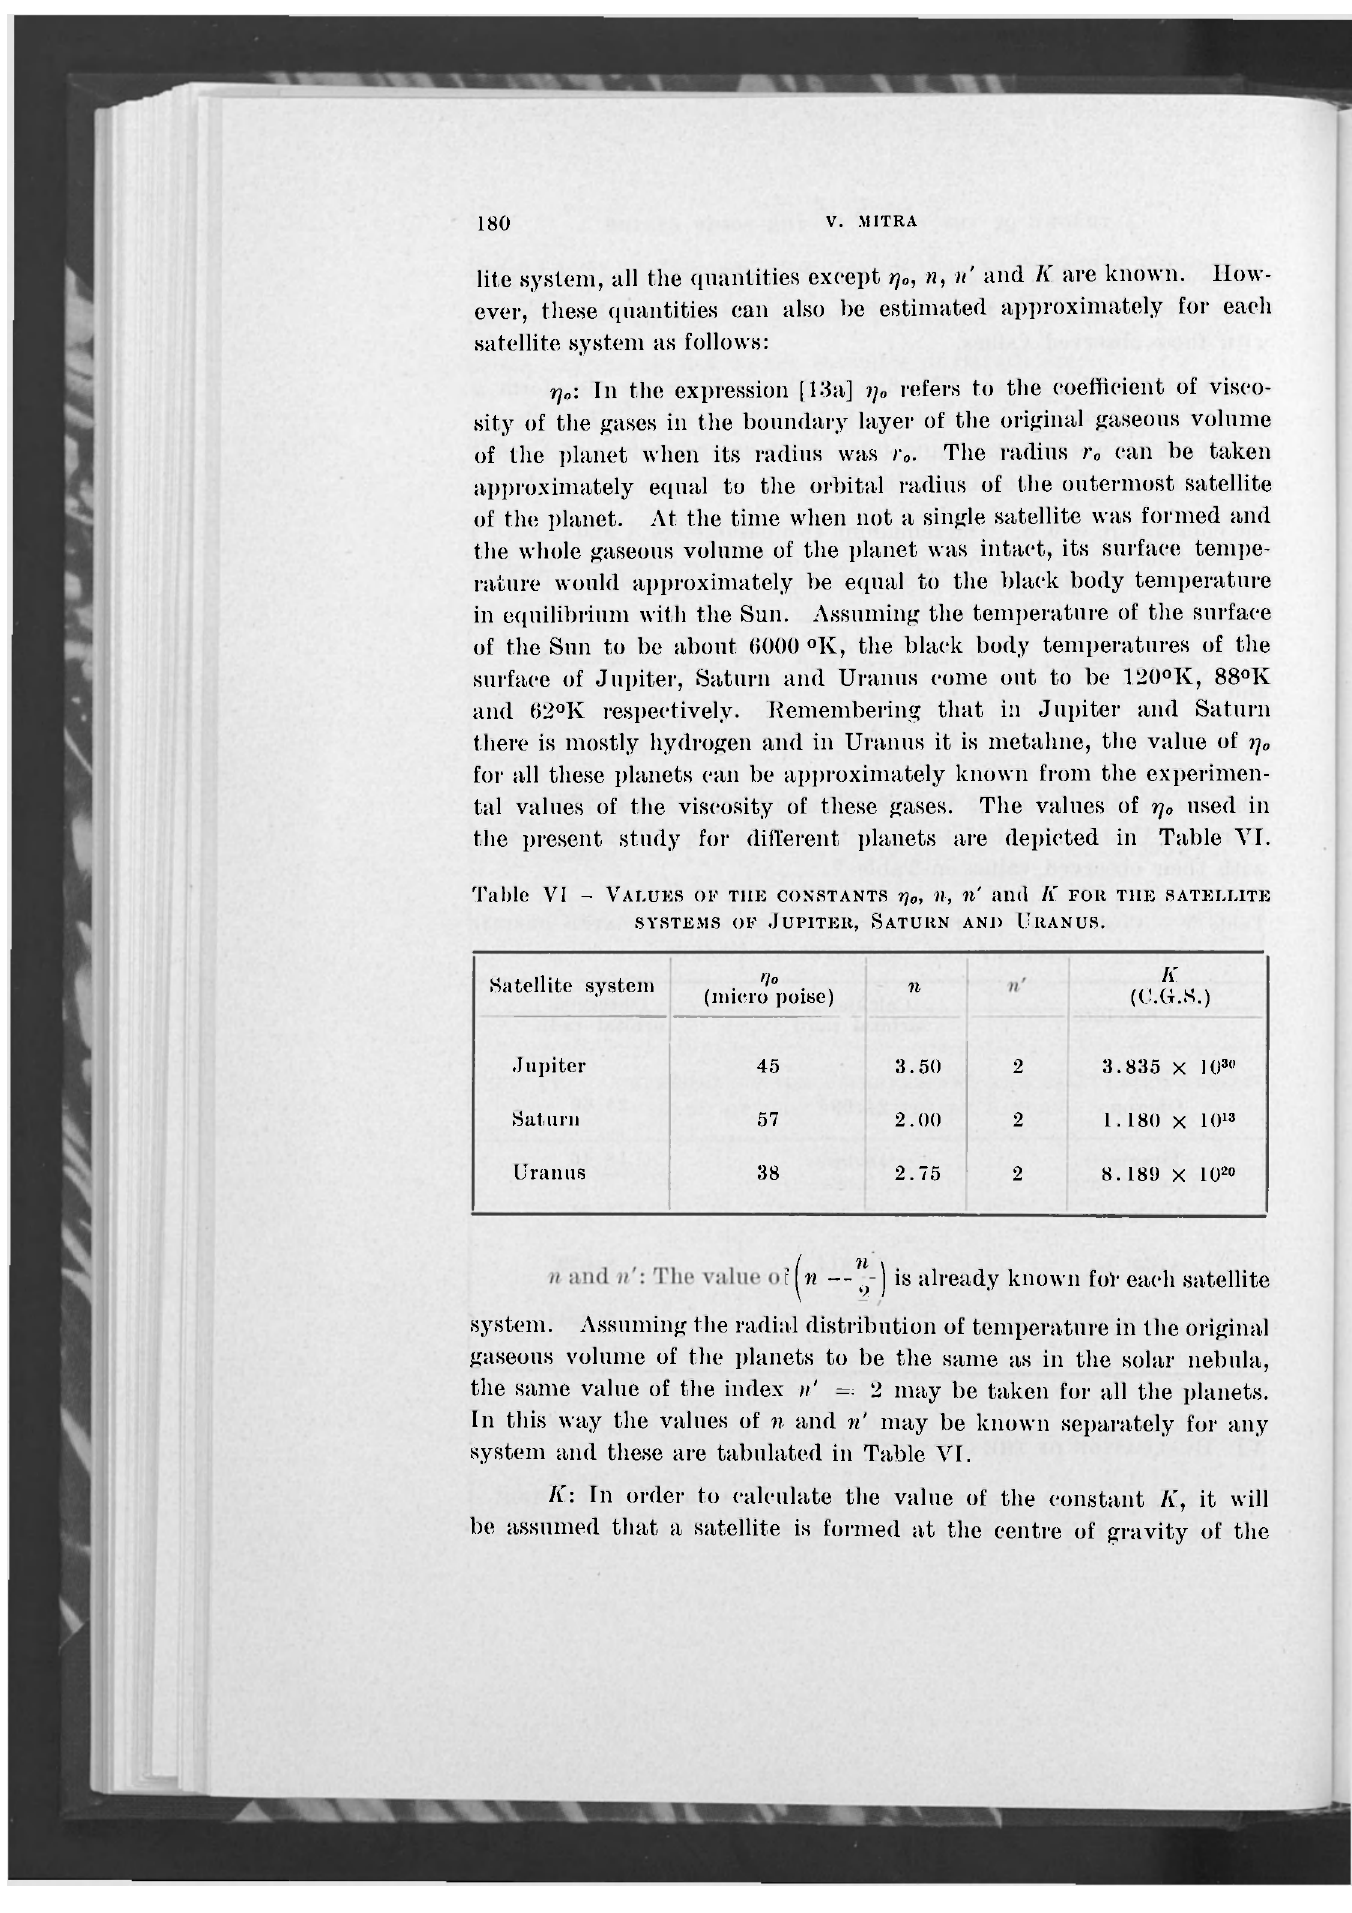
is already known for each satellite